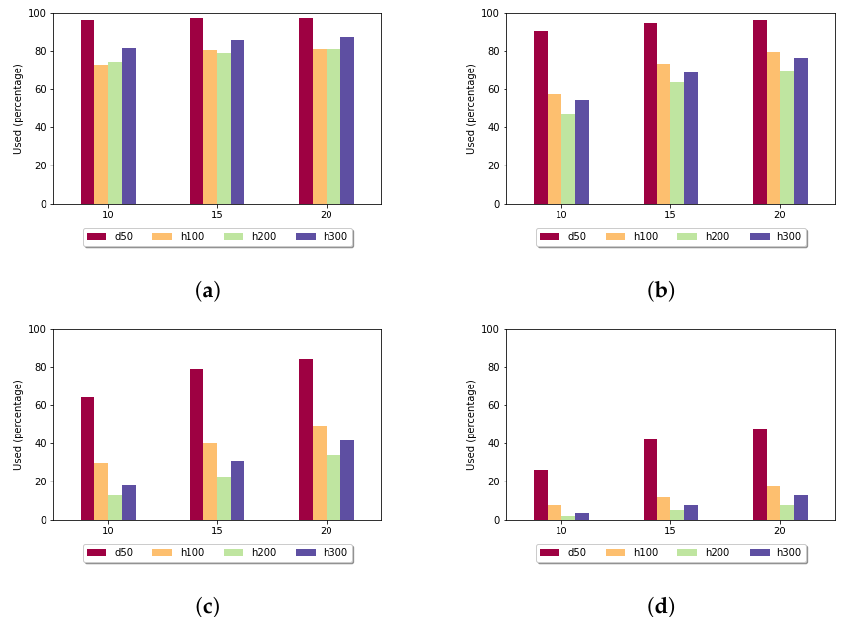
Figure 8. Utilization rate (y axis) depending on the size of the sample set (x axis) and length of the k-mers in the case of affine gap penalty: ( a ) k = 5; ( b ) k = 7; ( c ) k = 10; and ( d ) k = 15.